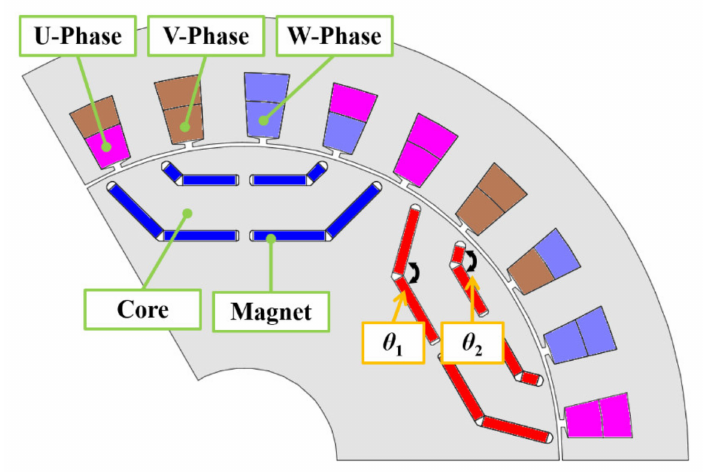
Figure 5. Configuration of the IPMSM and design variables.